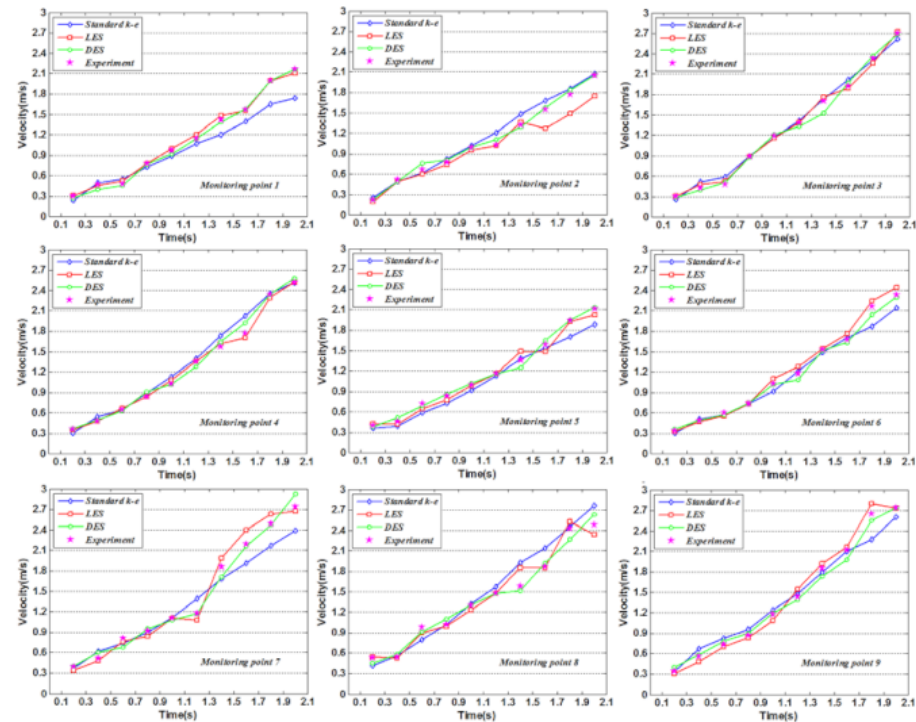
Figure 10. Prediction performance of three